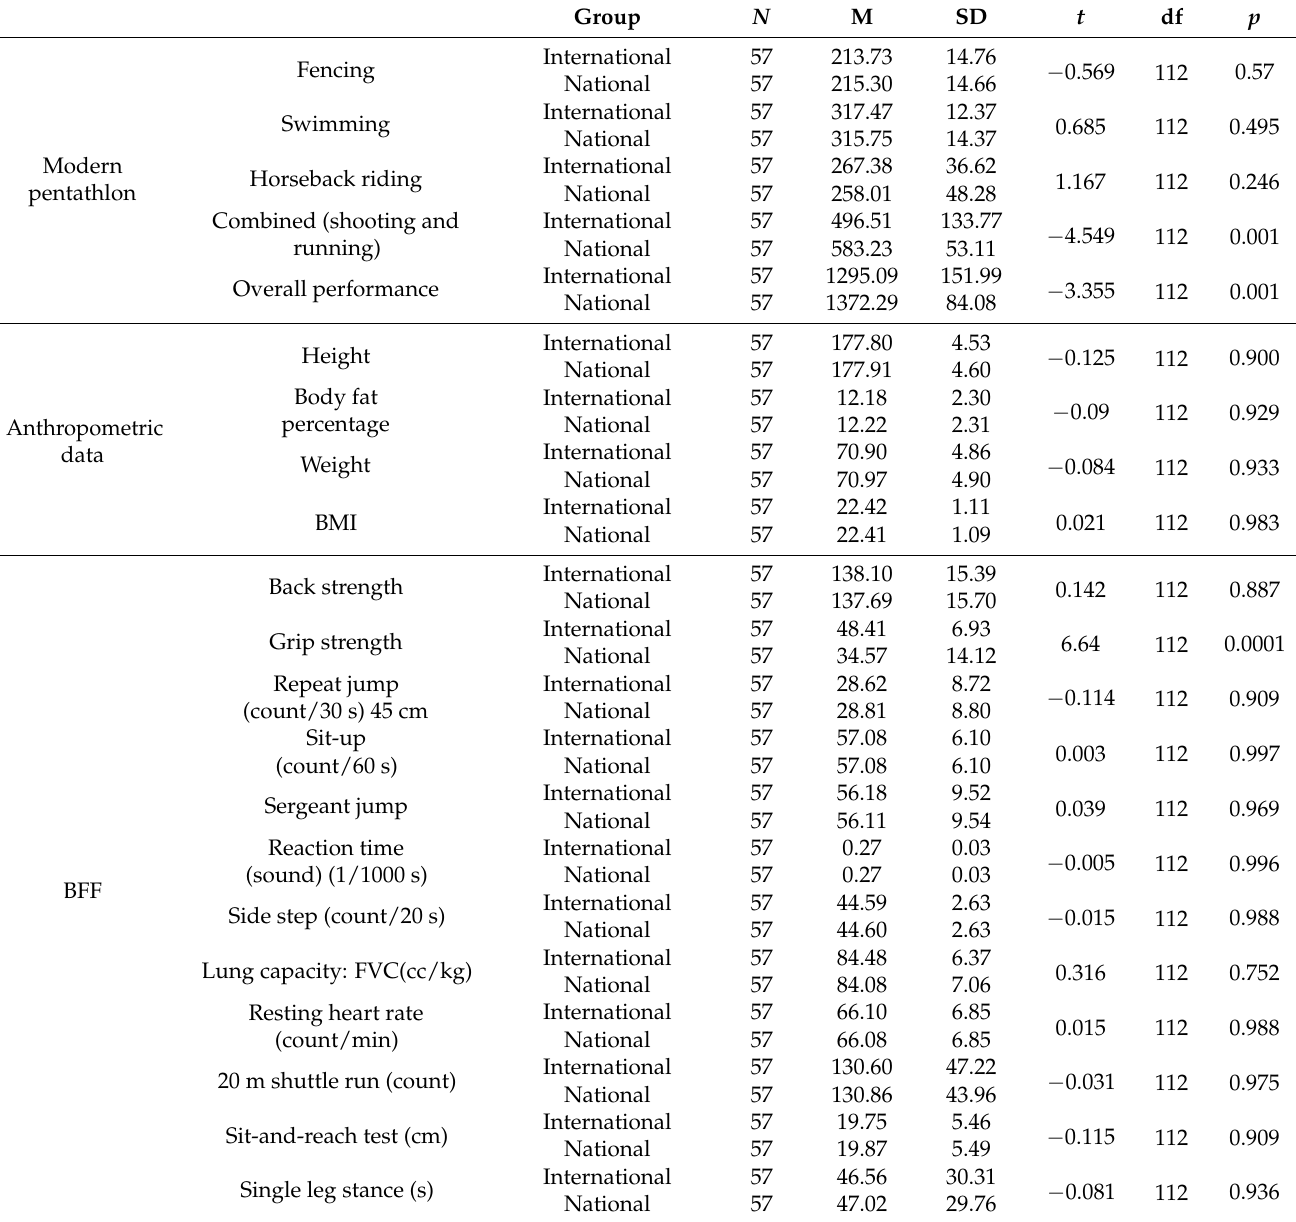
Table 5. Comparison of national and international competitions in modern pentathlon: basic fitness factors and anthropo- metric